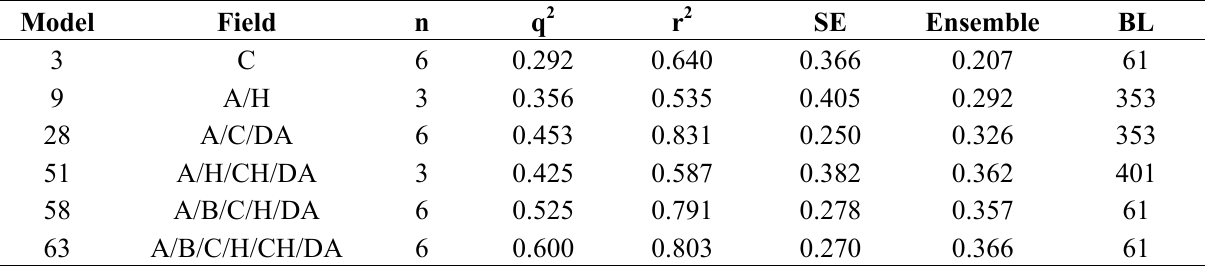
Table 2. Regression summary of HQSAR models combined with various fragment distinction parameters for the 64 Ts as inhibitors of [ 3 H]MK-801 binding in the presence of 30 µM of spermine a